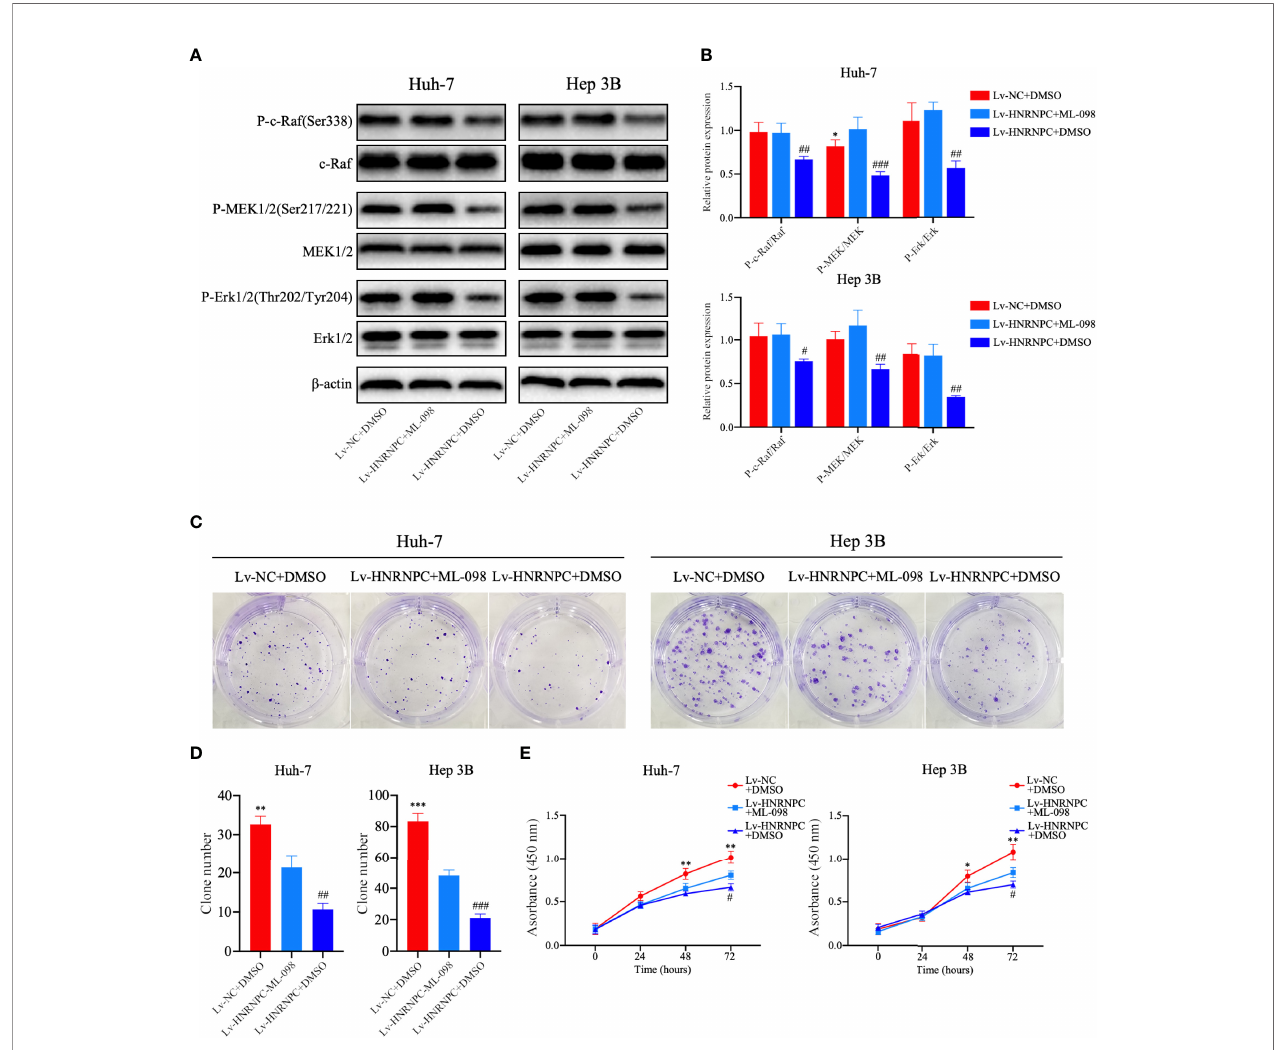
FIGURE 5 | After treatment with ML-098 (20 nmol/l), MAPK signaling pathway activation was recovered completely in Lv-HNRNPC-group cells, and proliferation ability was partially reversed. (A, B) Western blot to detect recovery of activation of the MAPK signaling pathway in Lv-HNRNPC groups after treatment with ML-098. (C, D) Colony formation assay showing the reversed ef fi ciency of ML-098 in Lv-HNRNPC group cell proliferation. (E) CCK-8 test showing the rescue by ML-098 of cell viability in the Lv-HNRNPC group. The tests mentioned above were operated three times respectively, and the results were reported as mean ± standard deviation (SD). *P < 0.05, **P < 0.01, ***P < 0.001, for Lv-NC+DMSO group compared with Lv-HNRNPC+ML-098 group; # P < 0.05, ## P < 0.01, ### P < 0.001, for Lv-HNRNPC+DMSO group compared with Lv-HNRNPC+ML-098